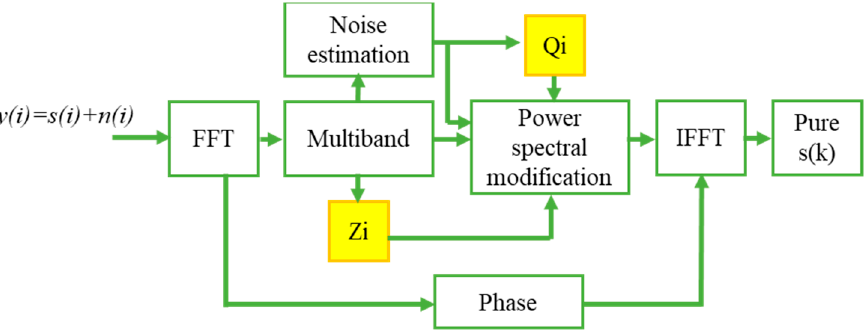
Figure 4. Nonlinear spectral